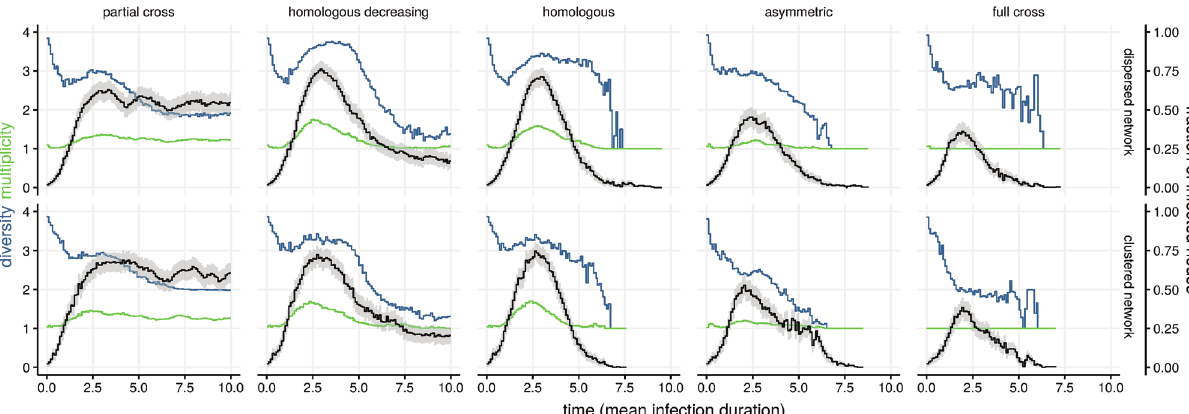
Fig 2. Genotype diversity index, multiplicity of infection (MOI), and epidemic prevalence as a function of network type and cross-immunity patterns. The figure shows the output of 50 stochastic epidemics with four genotypes on dispersed and clustered networks (see Table 1), and five immunological interference settings. Black lines show the time-averaged fraction of nodes infected with at least one genotype (95% confidence intervals shaded grey), blue lines show the average genotype diversity index at the population level, and green lines show the average MOI of individual nodes.